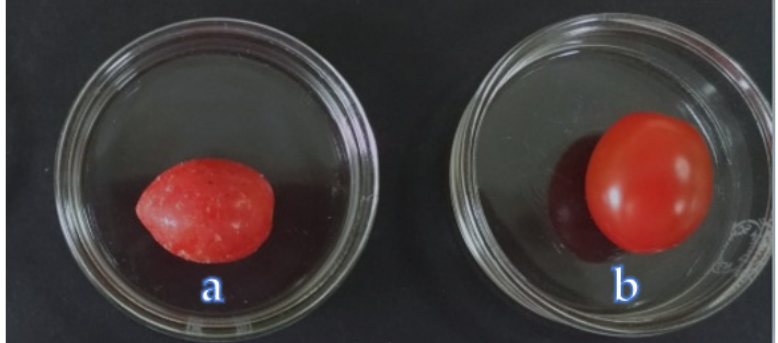
Figure 1. Cherry tomato coated with mucilage ( a ); uncoated cherry tomato ( b ).